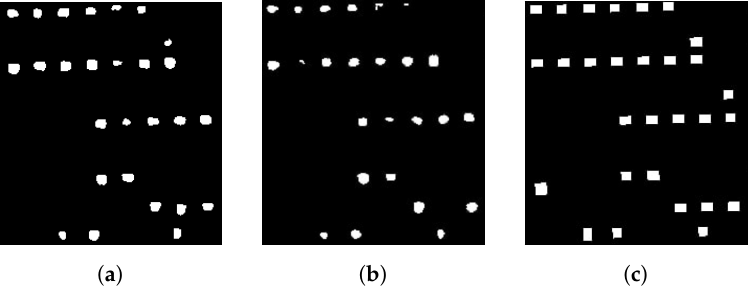
Figure 11. Detailed comparison of Fused-FCN4s and Hybrid-PS-Unet models. ( a ) presents the zoom-in area of building mask from Hybrid-PS-Unet model, ( b ) illustrates the capability of small building footprints generation by Fused-FCN4s and ( c ) is a ground